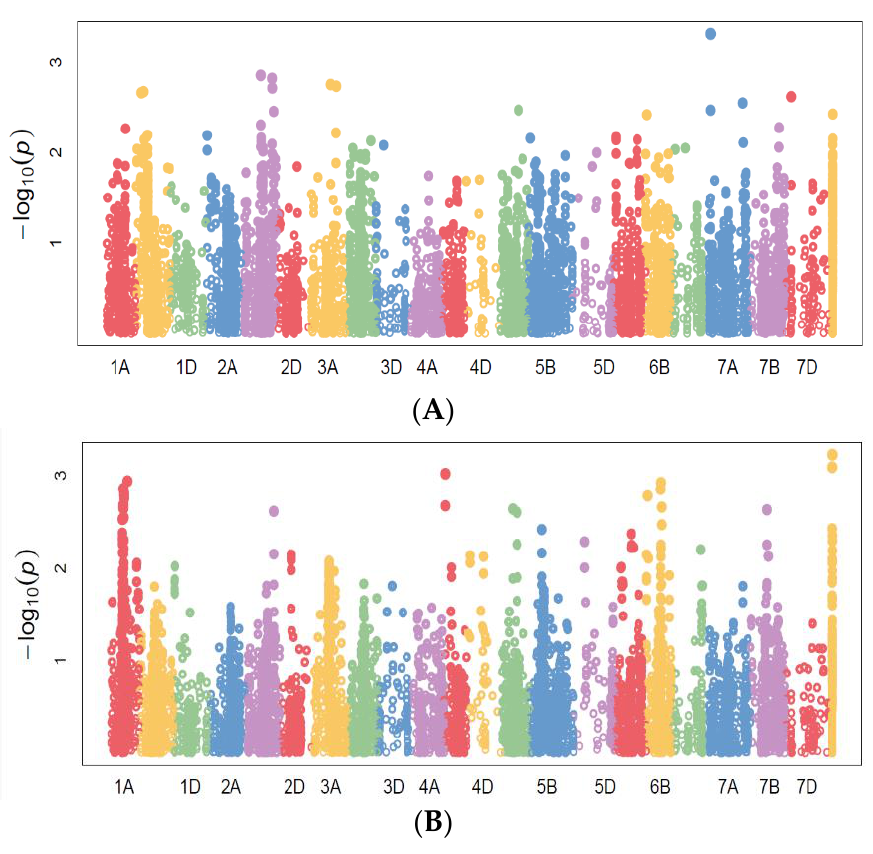
Figure 1. Manhattan plots showing SNP markers associated with grain yield at ( A ) Sidi El Aidi and ( B ) Taoujdate.